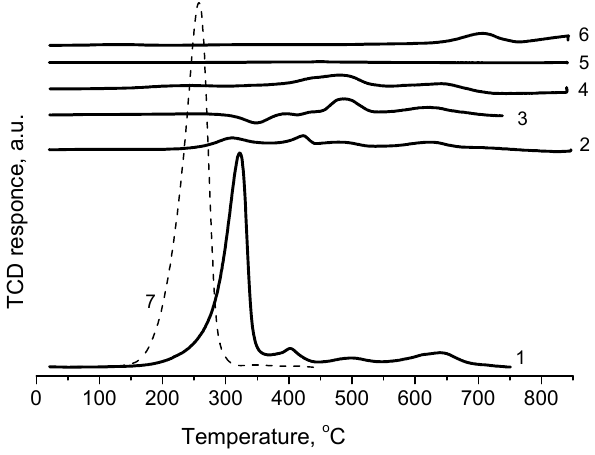
Figure 5. TPR-H 2 curves for the CuO-ZnO-SiO 2 and CuO-ZnO-SiO 2 -WC catalysts: 1 —CuO-ZnO-SiO 2 fresh; 2 —CuO-ZnO-SiO 2 -WC fresh; 3 —CuO-ZnO-SiO 2 after catalysis; 4 —CuO-ZnO-SiO 2 -WC after catalysis; 5 —ZnO; 6 —WC (scale 1 to 5); 7 —CuO. (All TPR curves are normalized to 1 g; the lysts).